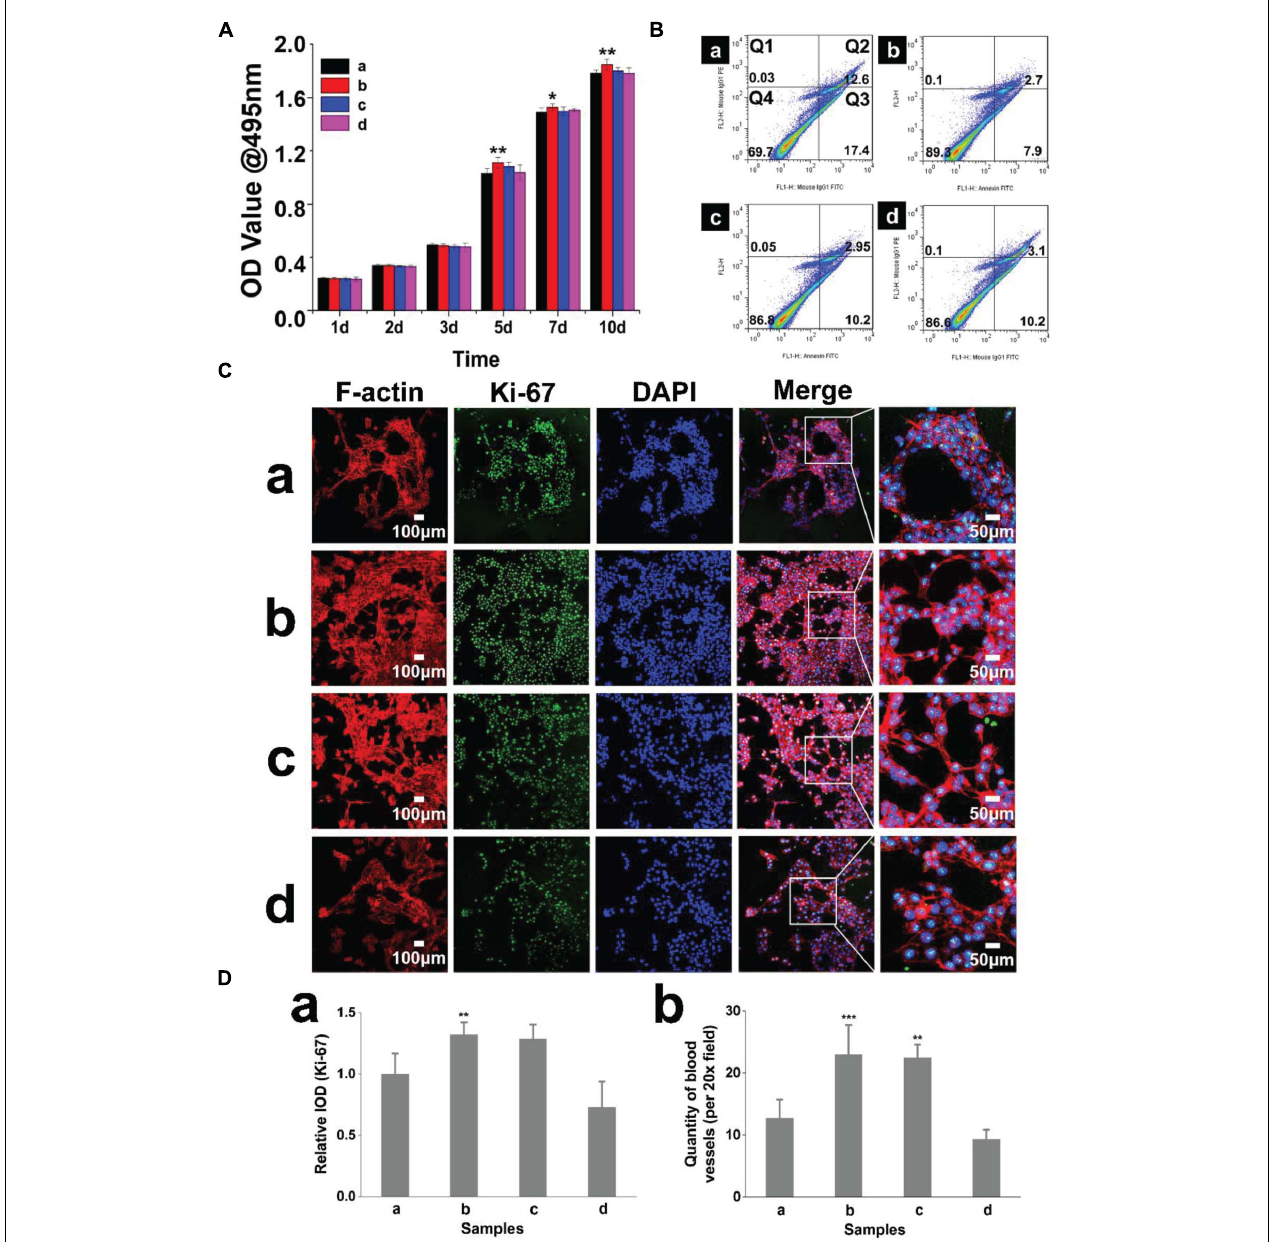
FIGURE 3 | Hydrogel biocompatibility and promotion of lumen formation. (A) The CCK-8 method was used to quantify the cytotoxicity of the hydrogels, and the growth of cells cultured with extracts of the hydrogel with 2% β -cd was slightly better than that of the other three groups. (Label descriptions: (a) pure GelMA, (b) with 2% β -cd, (c) with 3% β -cd, and (d) with 4% β -cd.) (Ba–d) Flow cytometric quadrantal diagrams showing the effect of hydrogels on HDMEC apoptosis. The addition of β -cd could significantly reduce the apoptosis of HDMECs planted on hydrogels, but there was no significant difference between different amounts of β -cd. (Ca–d) Immunofluorescence images of HDMECs seeded on hydrogels (Ki-67, F-actin). HDMECs seeded on all samples showed obvious, well-ordered actin stress fibers. After the addition of β -cd, the lumen formation of HDMECs on hydrogels was significantly improved. (Da,b) Quantitative determination of the fluorescence intensity of Ki-67 and lumen number. On the hydrogels with 2 and 3% β -cd addition, the Ki-67 fluorescence intensity of HDMECs was the highest. The vascular tubule formation of HDMECs was significantly increased in the GelMA + β -cd group compared with the pure GelMA group. (* P < 0.05 was considered statistically significant, and ** P < 0.01 and *** P < 0.001 were considered extremely significant).